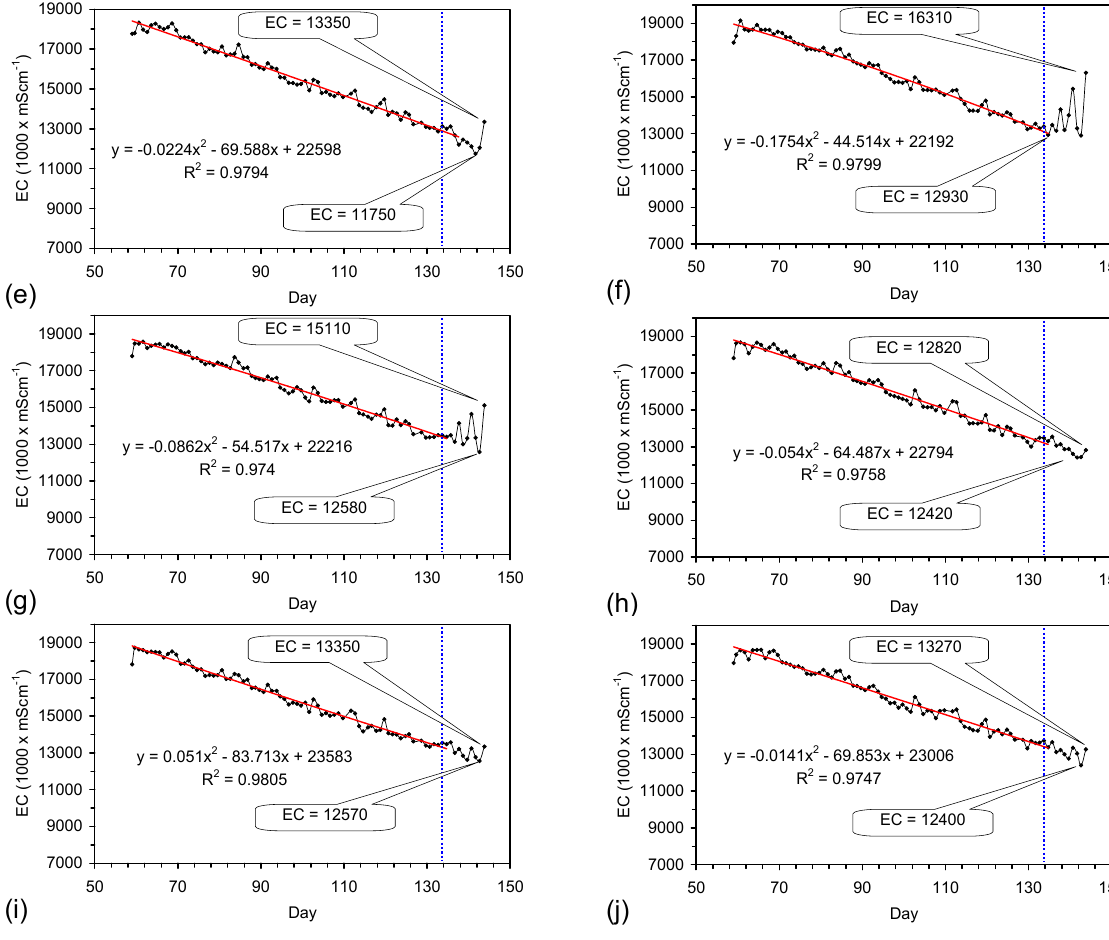
Figure D6. Feed Water EC = 17.890 mS·cm − 1 . ( a ) S5:T1; D = 0.0054; R 2 =